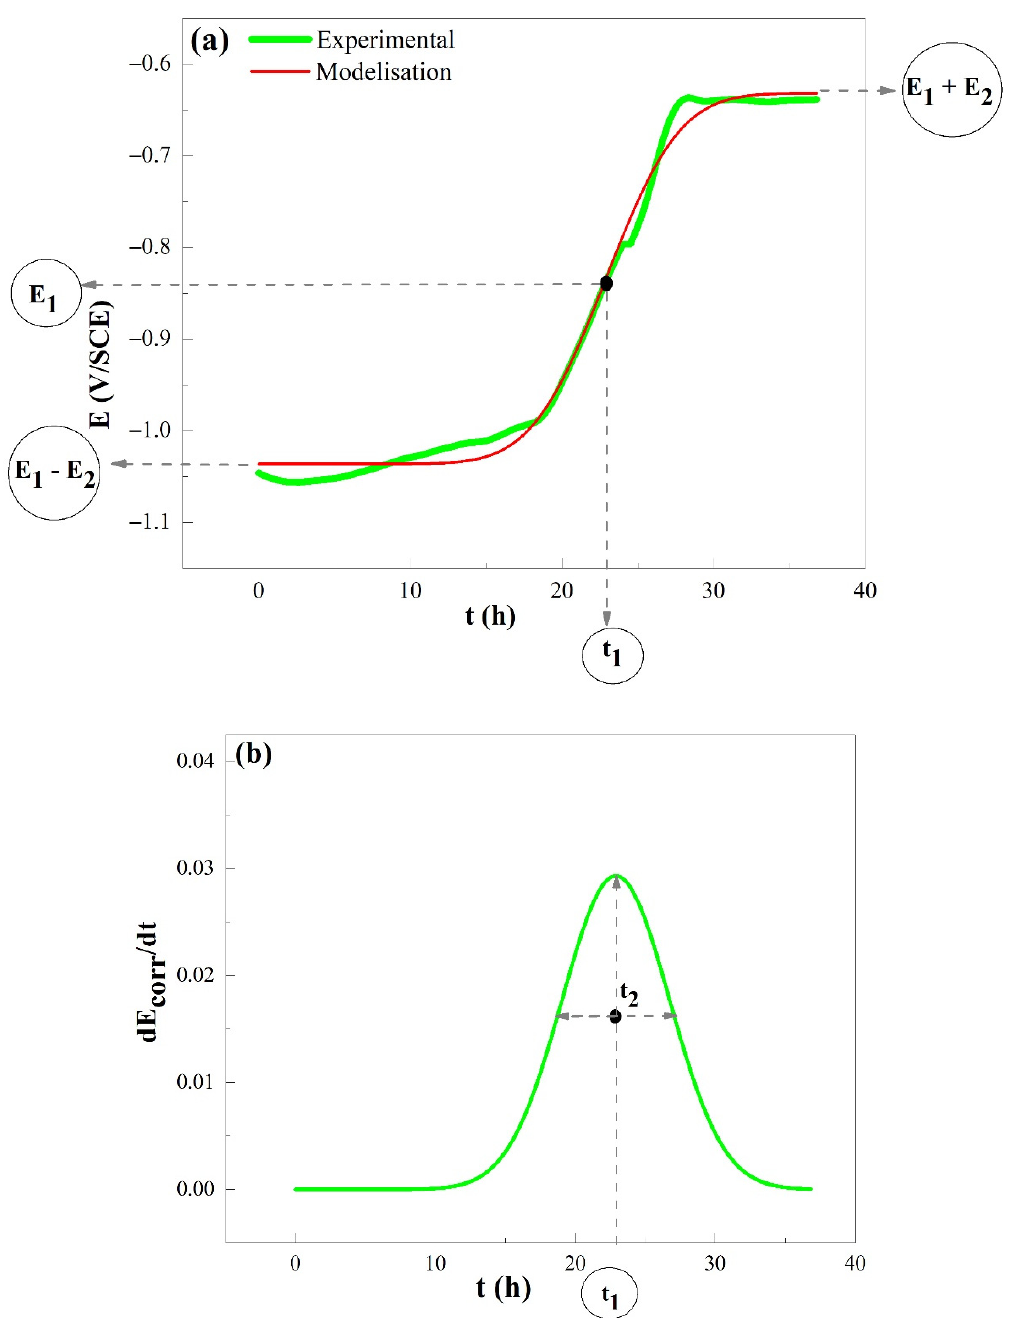
Figure 5. Example of modeled curve of open-circuit potential ( a ): simulation and ( b ) derivative (elaboration parameters: t = 30 min, E = − 1.6 V/SCE, and B = 0.3 T). It can be observed from Table 2 that: − Whatever the magnetic field amplitude, t 1 is greatly decreased when the cathodic potential increased.